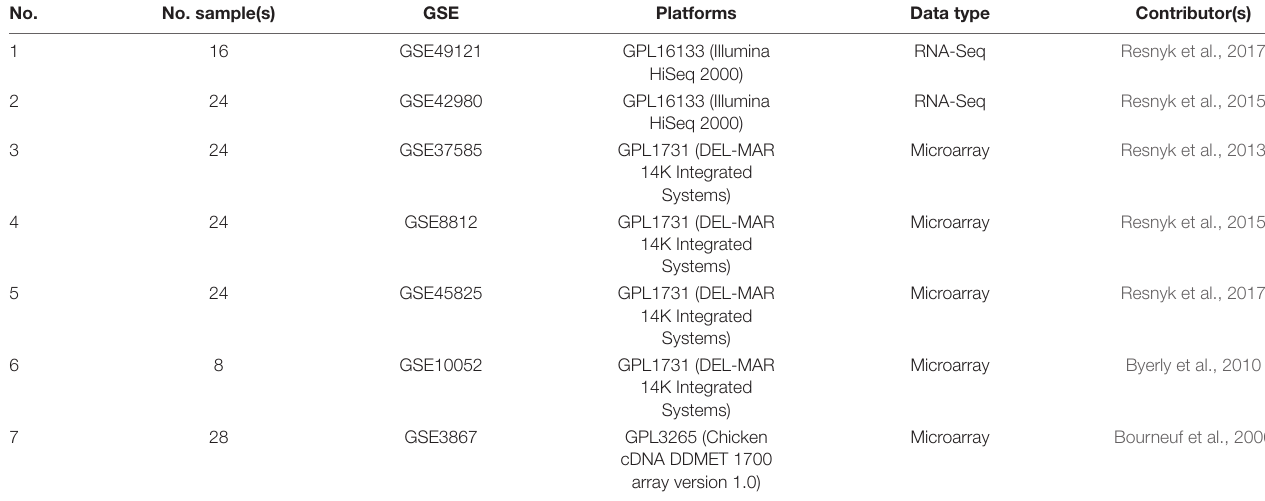
TABLE 1 | GEO accession numbers for RNA-Seq and microarray data sets.